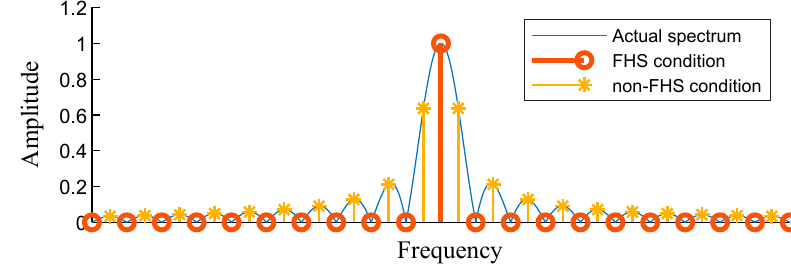
Figure 2. FFT spectra of sinusoidal waves affected by the condition of FPS.